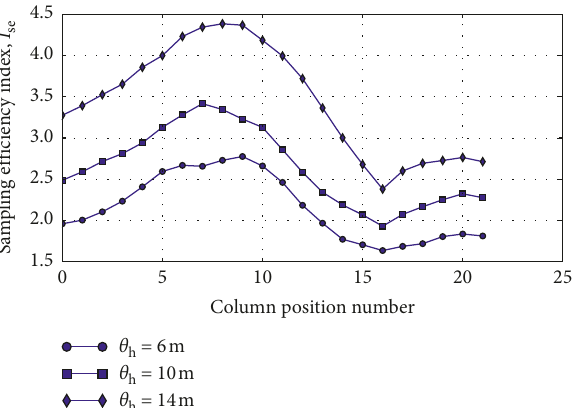
(2 CPT sampling, 1st CPT fixed at i � 16), h